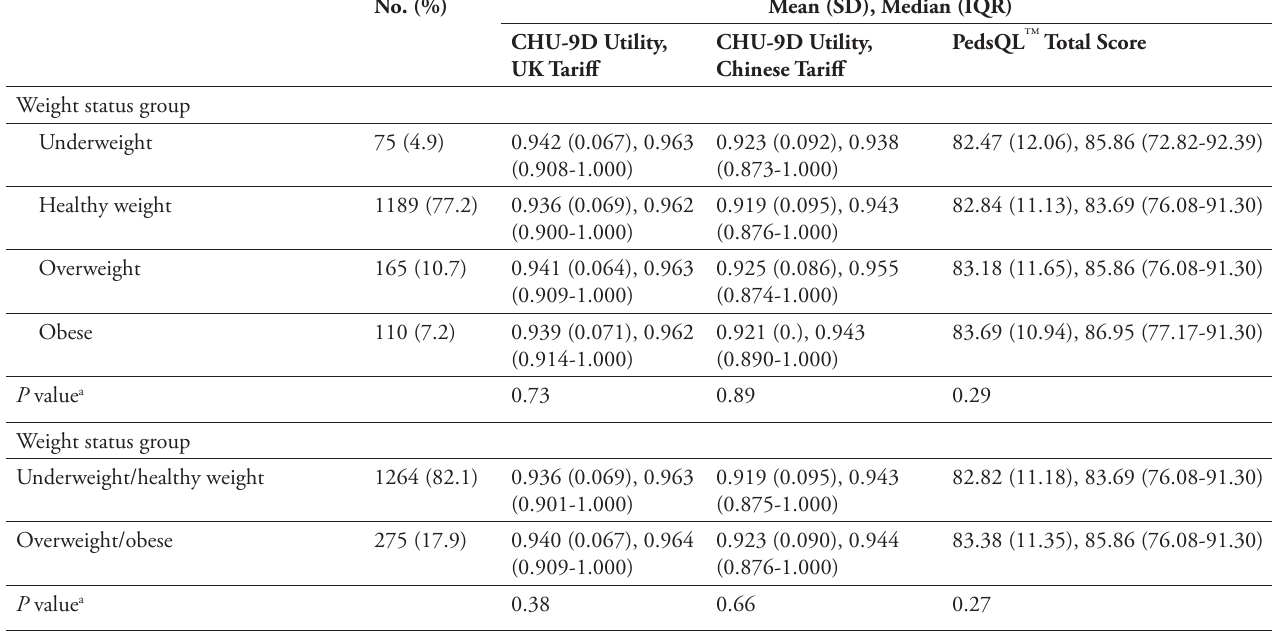
Table 2. Mean (SD) and Median (IQR) for CHU-9D and PedsQL tm Scores Based on Weight Status